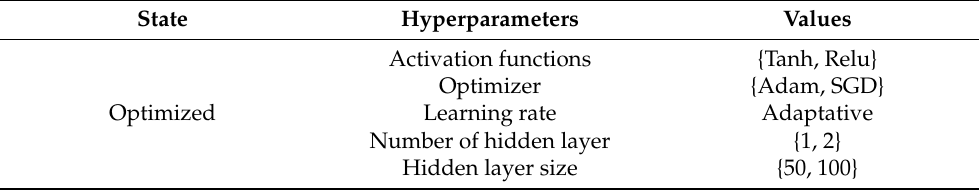
Table 1. Overview of the hyperparameter space used in the optimization of the